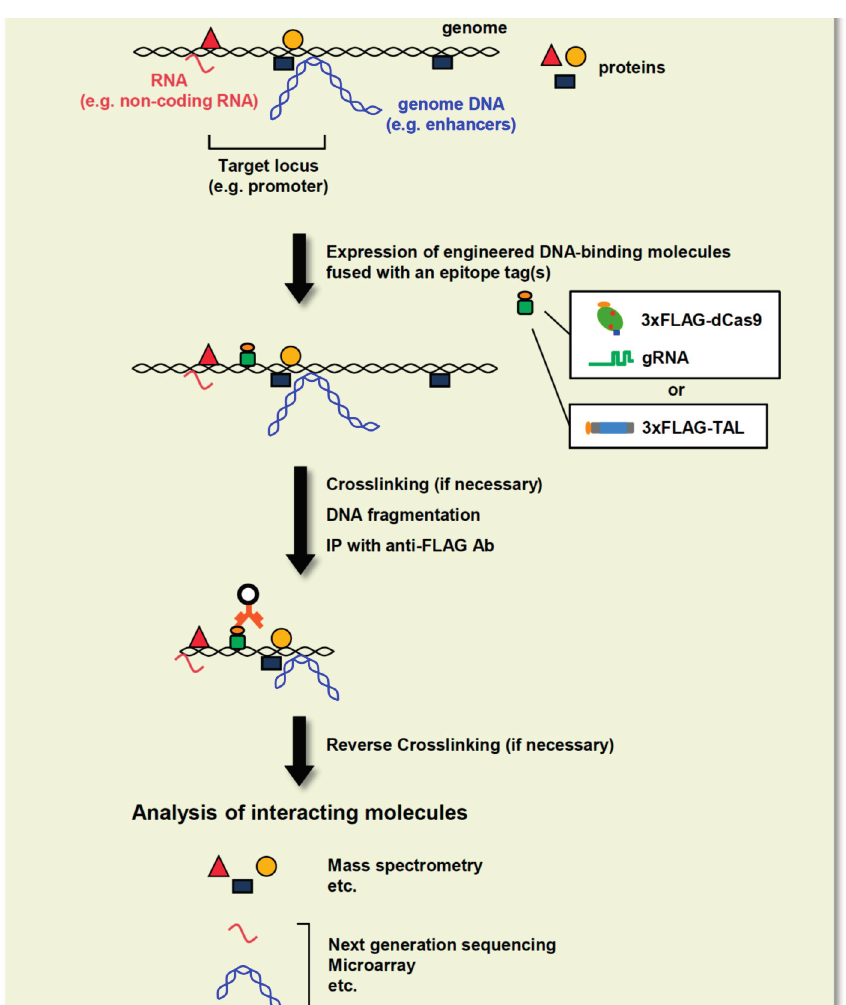
Figure 5. enChIP using TAL or CRISPR/Cas. To isolate genomic regions of interest from cells, TAL or dCas9/sgRNA is designed and expressed in the cells to be analyzed. The cells are crosslinked (if necessary) and lysed, and the genomic DNA is fragmented by sonication or other methods. Chromatin complexes of the target region are immunoprecipitated with an Ab against the epitope tag (e.g., 3xFLAG-tag) fused to TAL or dCas9. Alternatively, chromatin complexes of the target region can be affinity-purified with an Ab against TAL or dCas9. Comprehensive identification of molecules (DNA, RNA, proteins, etc. ) bound to the isolated genome complexes enables elucidation of the molecular mechanisms underlying genome functions. Interacting RNA: red line; interacting genomic DNA: blue line; interacting proteins: red triangle, orange circle, and dark blue rectangle; Ab fused with a carrier: orange line fused with